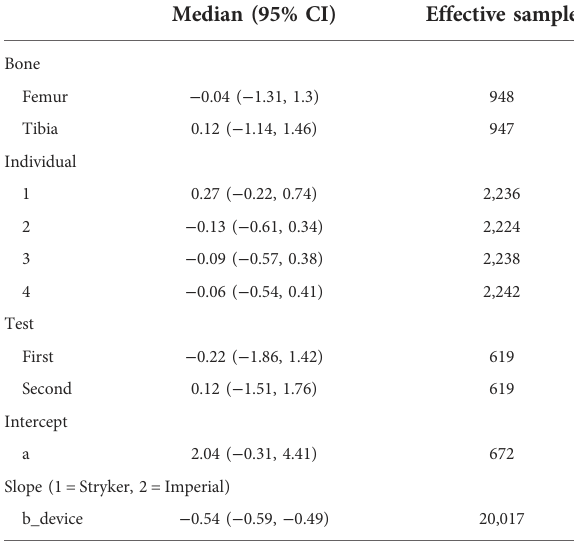
TABLE 5 Average effect of the parameters in the models, 95% con fi dence intervals, and effective samples sizes for each